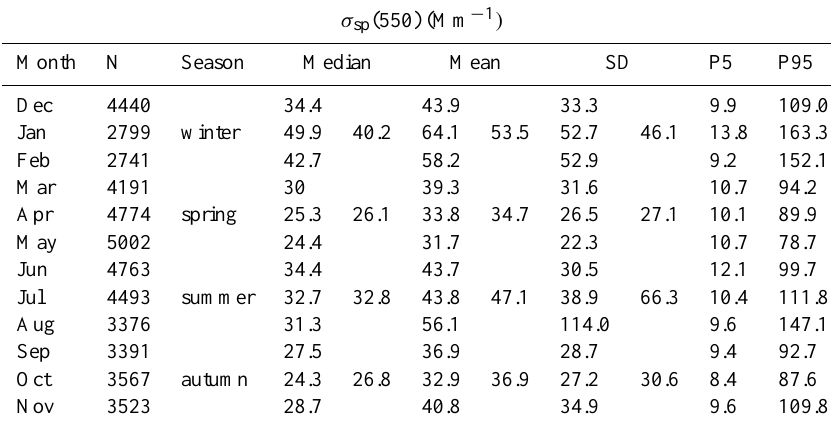
Table 5a. Basic statistical properties of σ sp (550) organized for each month and season between 2002 and